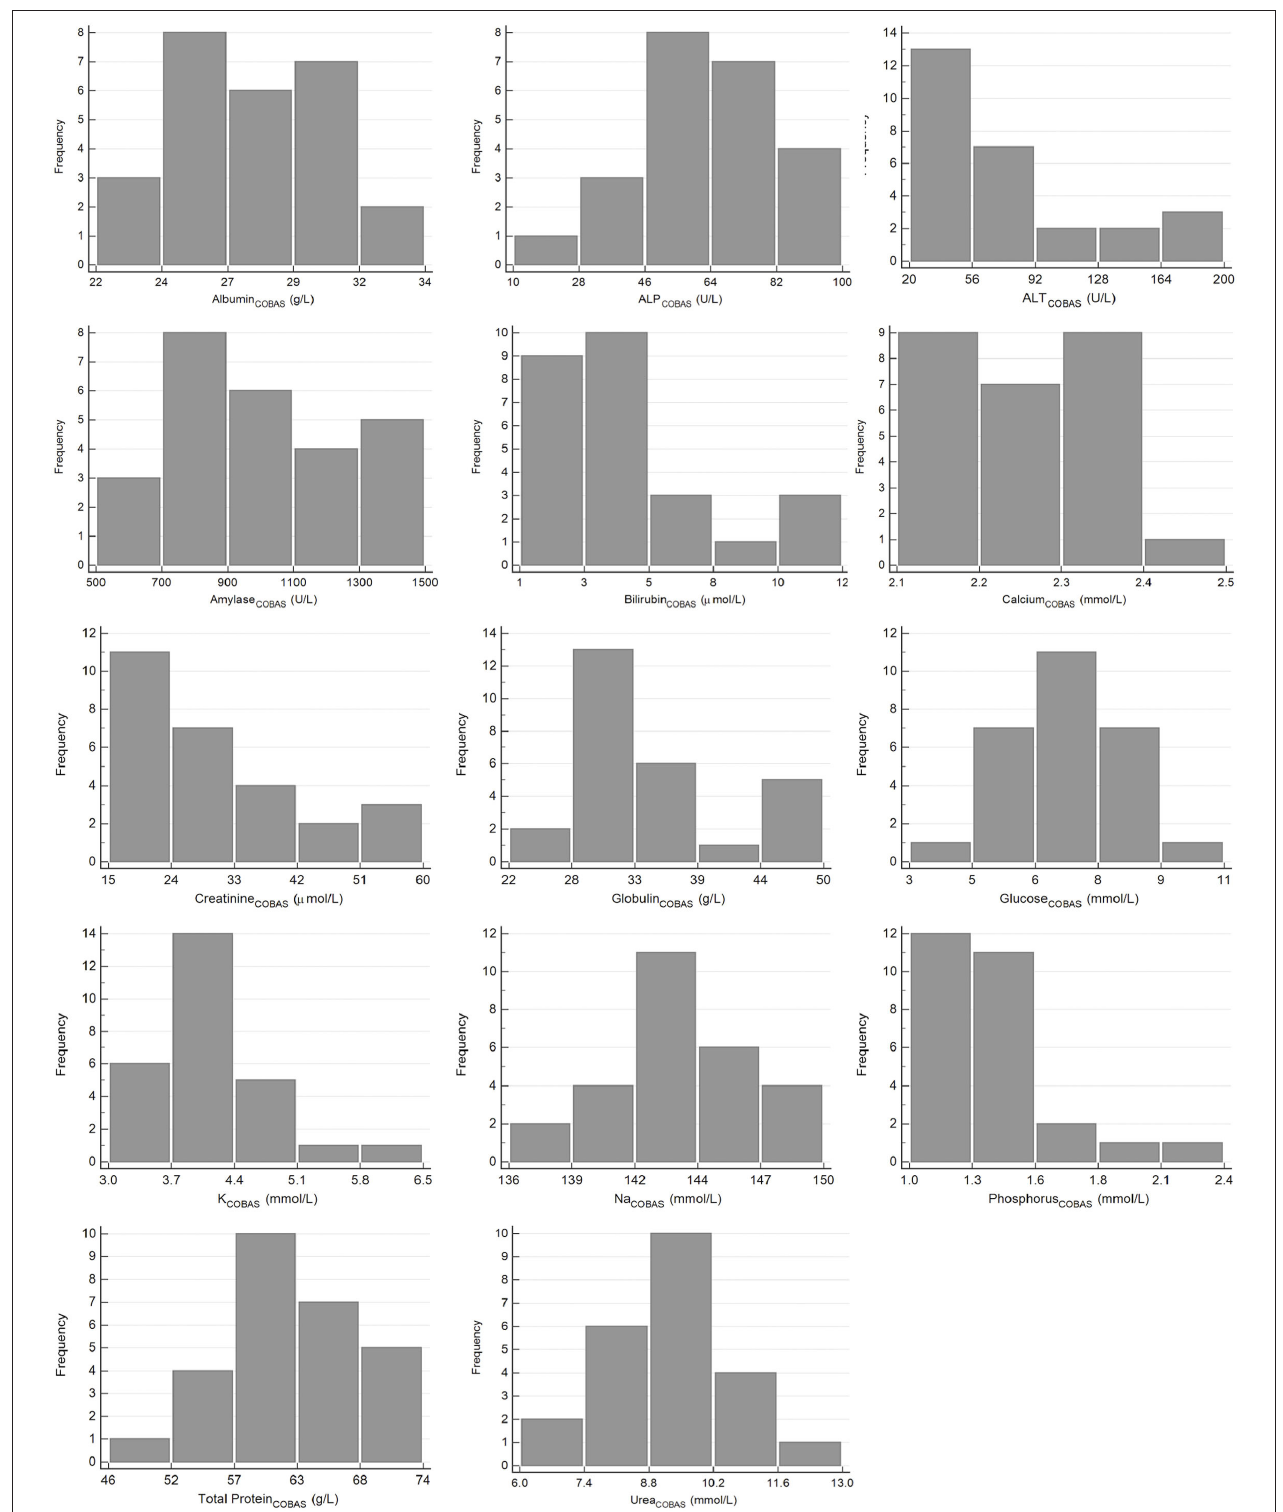
FIGURE 3 | Histograms showing the distribution of results for plasma clinical chemistry measurands from Temminck’s pangolin for the Roche Cobas Integra 400 Plus. The x-axis represents the measurand result; the y-axis represents the frequency of these values occurring.